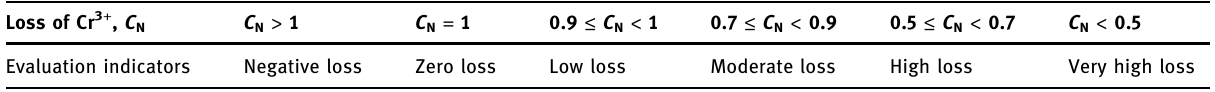
Table 1: Evaluation indicators for the loss of Cr 3 + in polymer gel Loss of Cr 3 + , C